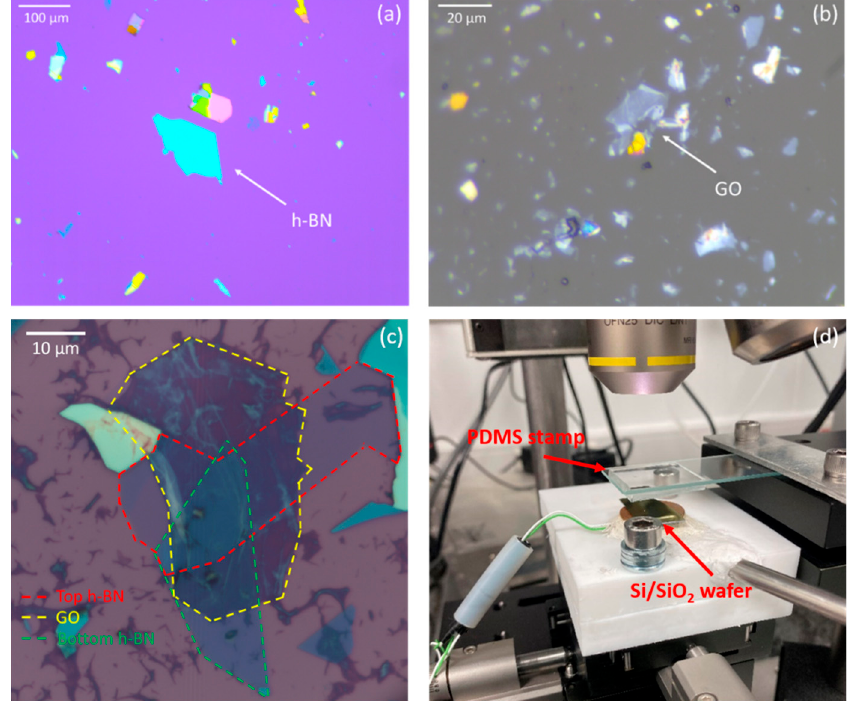
Figure 2. ( a ) h-BN and ( b ) GO flakes obtained by mechanical exfoliation. ( c ) Full h-BN -GO- h-BN heterostructure. ( d ) Staking system for the fabrication of high-quality 2D heterostructures at USAL- NANOLAB.